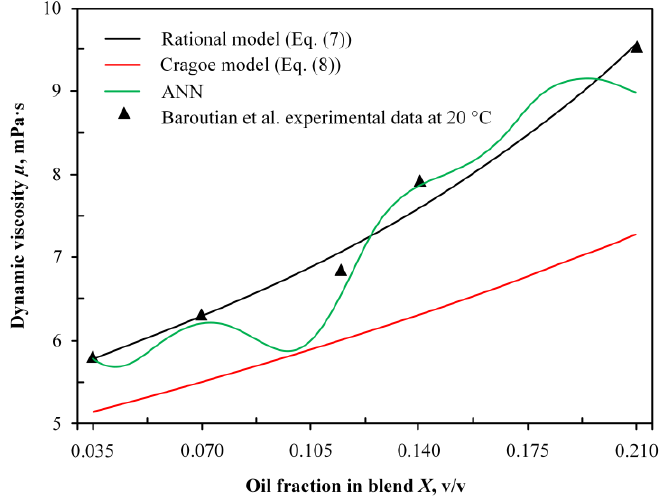
Fig. 9. Variation in dynamic viscosity vs. oil fraction at 20 °C (for high oil